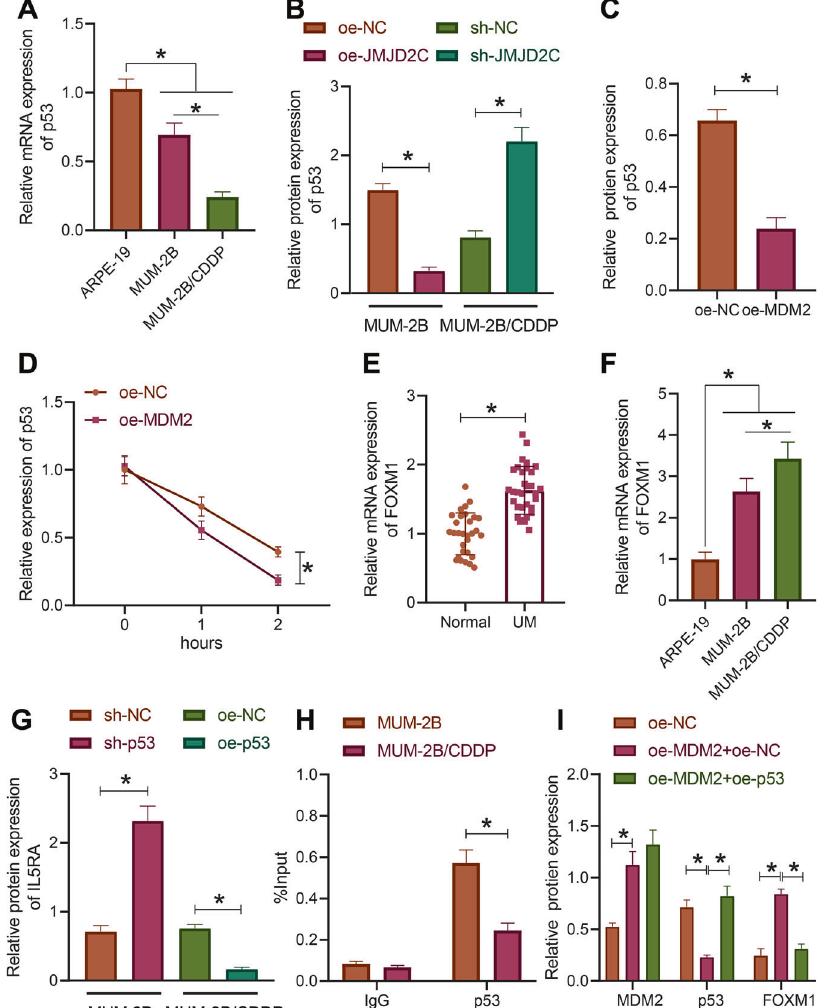
Fig. 4 MDM2 degrades p53 through ubiquitination and promotes the expression of IL5RA. A The expression of p53 in normal uveal epithelial cells ARPE-19, uveal melanoma cells MUM-2B, and drug-resistant cell line MUM-2B/CDDP as determined by RT-qPCR. B The expression of p53 in MUM-2B/CDDP cells upon JMJD2C silencing and MUM-2B cells upon JMJD2C overexpression as measured by Western blot assay. C The expression of p53 in MUM-2B cells upon MDM2 overexpression as measured by Western blot assay. D The stability of p53 protein after CHX treatment. E The expression of IL5RA in uveal melanoma tissues as determined by RT-qPCR (uveal melanoma = 32, normal = 30). F The expression of IL5RA in normal uveal epithelial cells ARPE-19, uveal melanoma cells MUM-2B and drug-resistant cell line MUM-2B/ CDDP as determined by RT-qPCR. G IL5RA expression in MUM-2B/CDDP cells upon p53 overexpression and MUM-2B cells upon p53 silencing measured by Western blot assay. H The enrichment of p53 in the IL5RA promoter region in MUM-2B/CDDP cells and MUM-2B cells analyzed by ChIP. I The expression of MDM2, p53, and IL5RA in MUM-2B cells treated with oe-MDM2 or combined with oe-p53 as measured by Western blot assay. * p < 0.05. Cell experiments were repeated three times